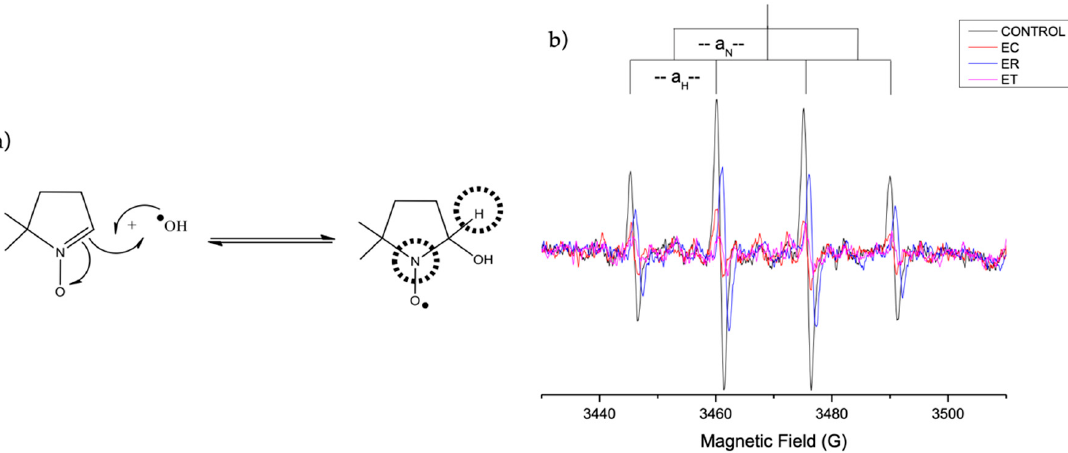
Figure 4. DMPO-OH spin adduct formation reaction ( a ) and EPR spectra of A. radiata ethanolic extracts ( b ).